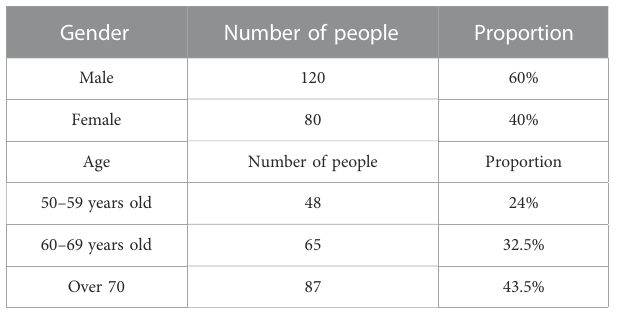
TABLE 1 Experimental object data.